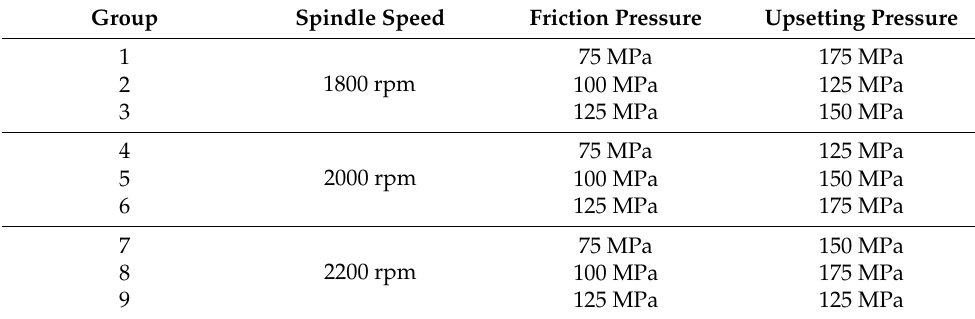
Table 2. Process parameters of CDFW.